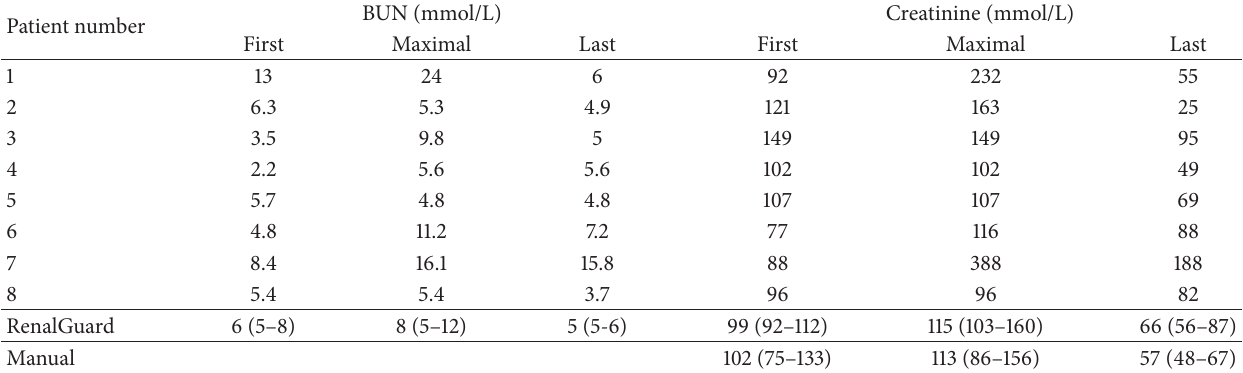
Deviation (above or below) from set target balance (mL)